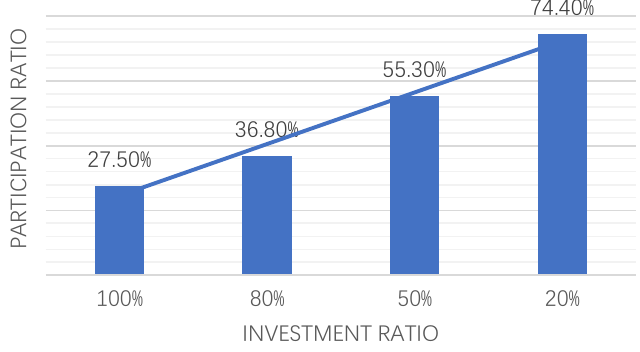
Figure 4. Relationship between participation ratio and investment ratio.